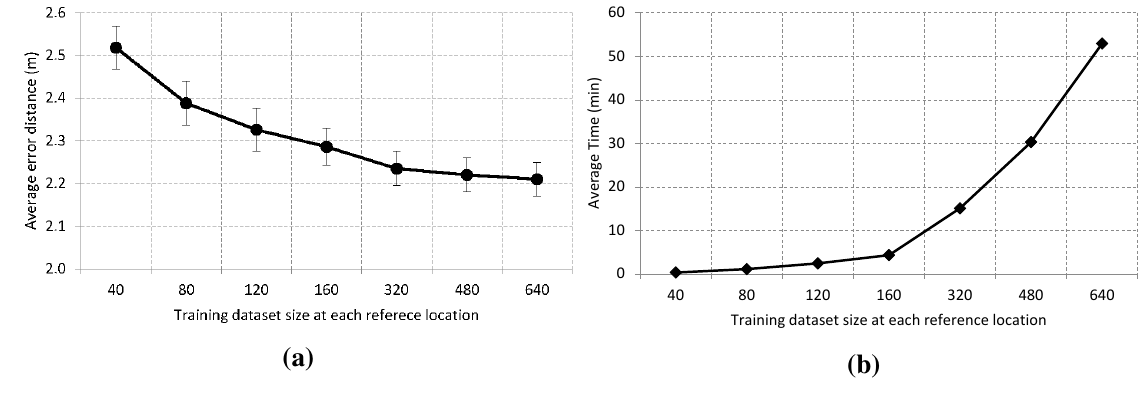
Figure 5. Effect of the training size at each reference location on the: ( a ) performance of the proposed system; ( b ) elapsed time to build the model of multiple weighted decision